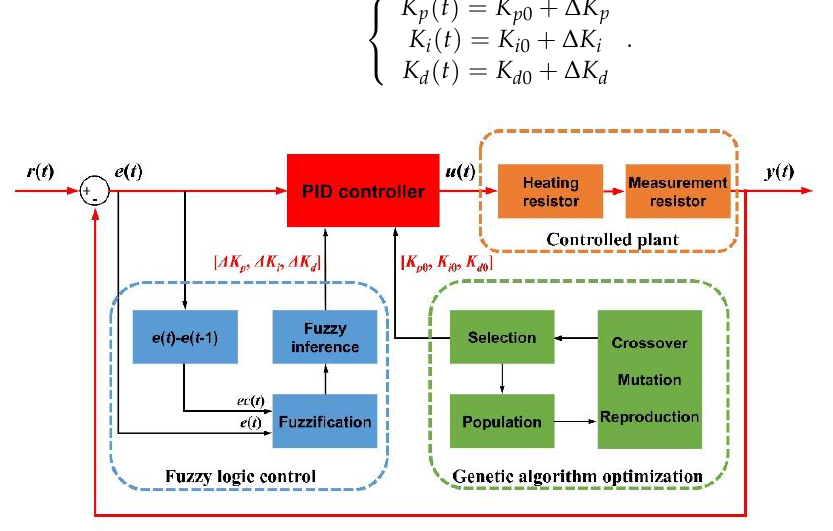
Figure 3. Framework of temperature control methods.